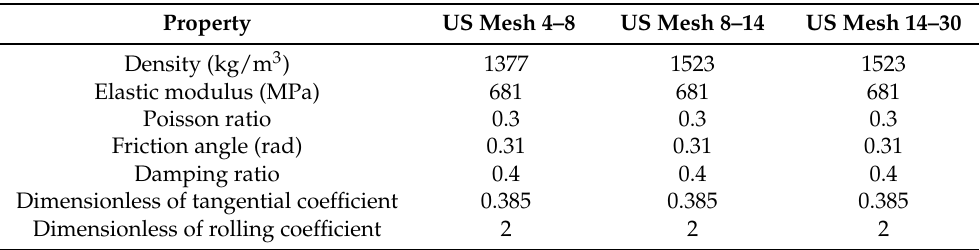
Table 1. The characteristics of the coke particles used in the discrete element method (DEM) model